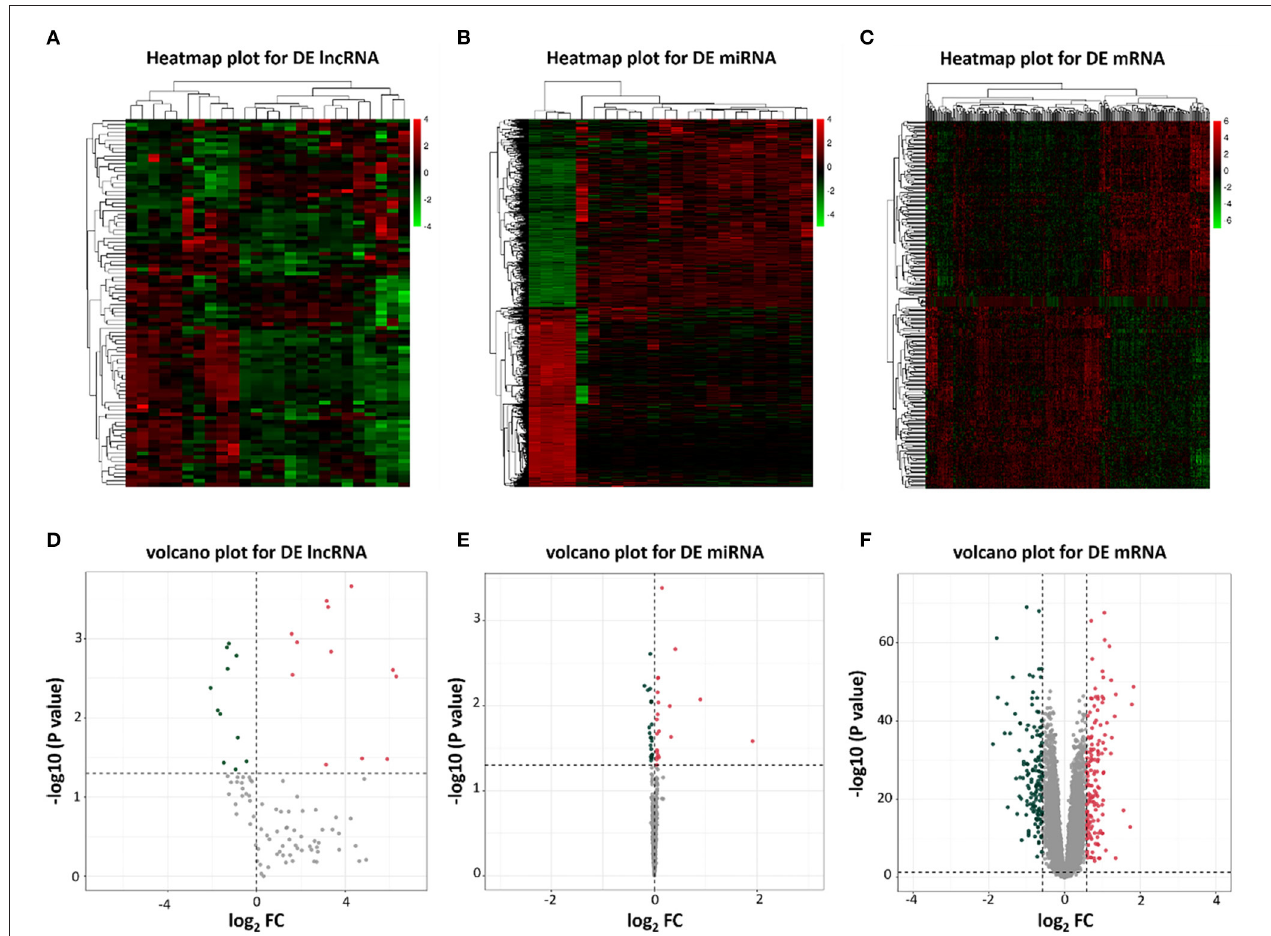
FIGURE 2 | Heatmap plots and volcano plots of differentially expressed lncRNAs, miRNAs, and mRNAs. (A) Heatmap of differentially expressed lncRNAs; (B) Heatmap of differentially expressed miRNAs; (C) Heatmap of differentially expressed mRNAs; (D) Volcano plot of 23 differentially expressed lncRNAs; (E) Volcano plot of 46 differentially expressed miRNAs; (F) Volcano plot of 300 differentially expressed mRNAs. Red represents upregulated genes and green indicates downregulated genes. DE, differentially expressed; FC, fold